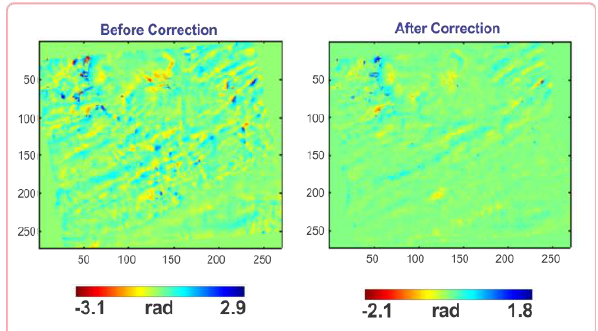
Figure 6. Phase difference map calculated by differencing the phase values between each PS points joint by Delaunay edges before (left) and after (right) correction. It is assumed that all of spatially correlated components have been removed. It can be seen phase difference map was smoothed after this correction.